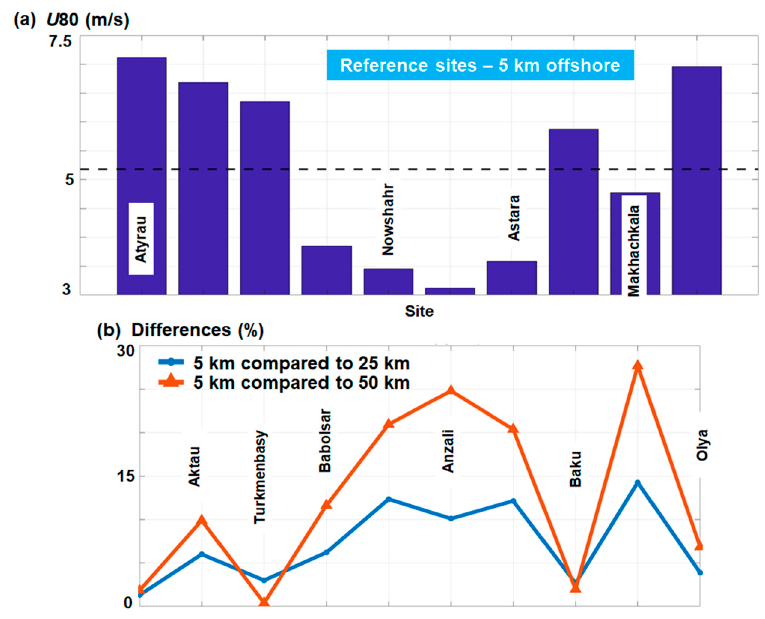
Figure 5. The distribution of the U 80 parameter (average values) per reference sites considering the 20-year time interval of ERA-Interim data, where: ( a ) U 80 values reported by the sites located at 5 km nearshore; ( b ) differences (in %) between the sites located at 5 km and the ones located at 25 km and 50 km, respectively.